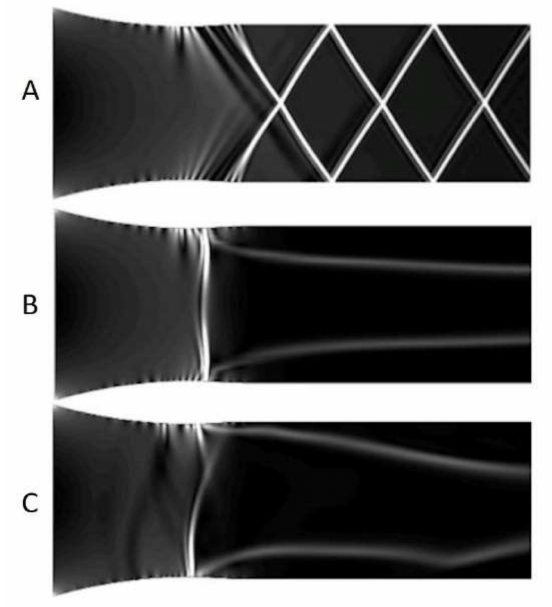
Figure 6. The numerical Schlieren for inviscid flow in parallel nozzle with humidity equal to ( A ) 0%, ( B ) 51.6%, ( C )